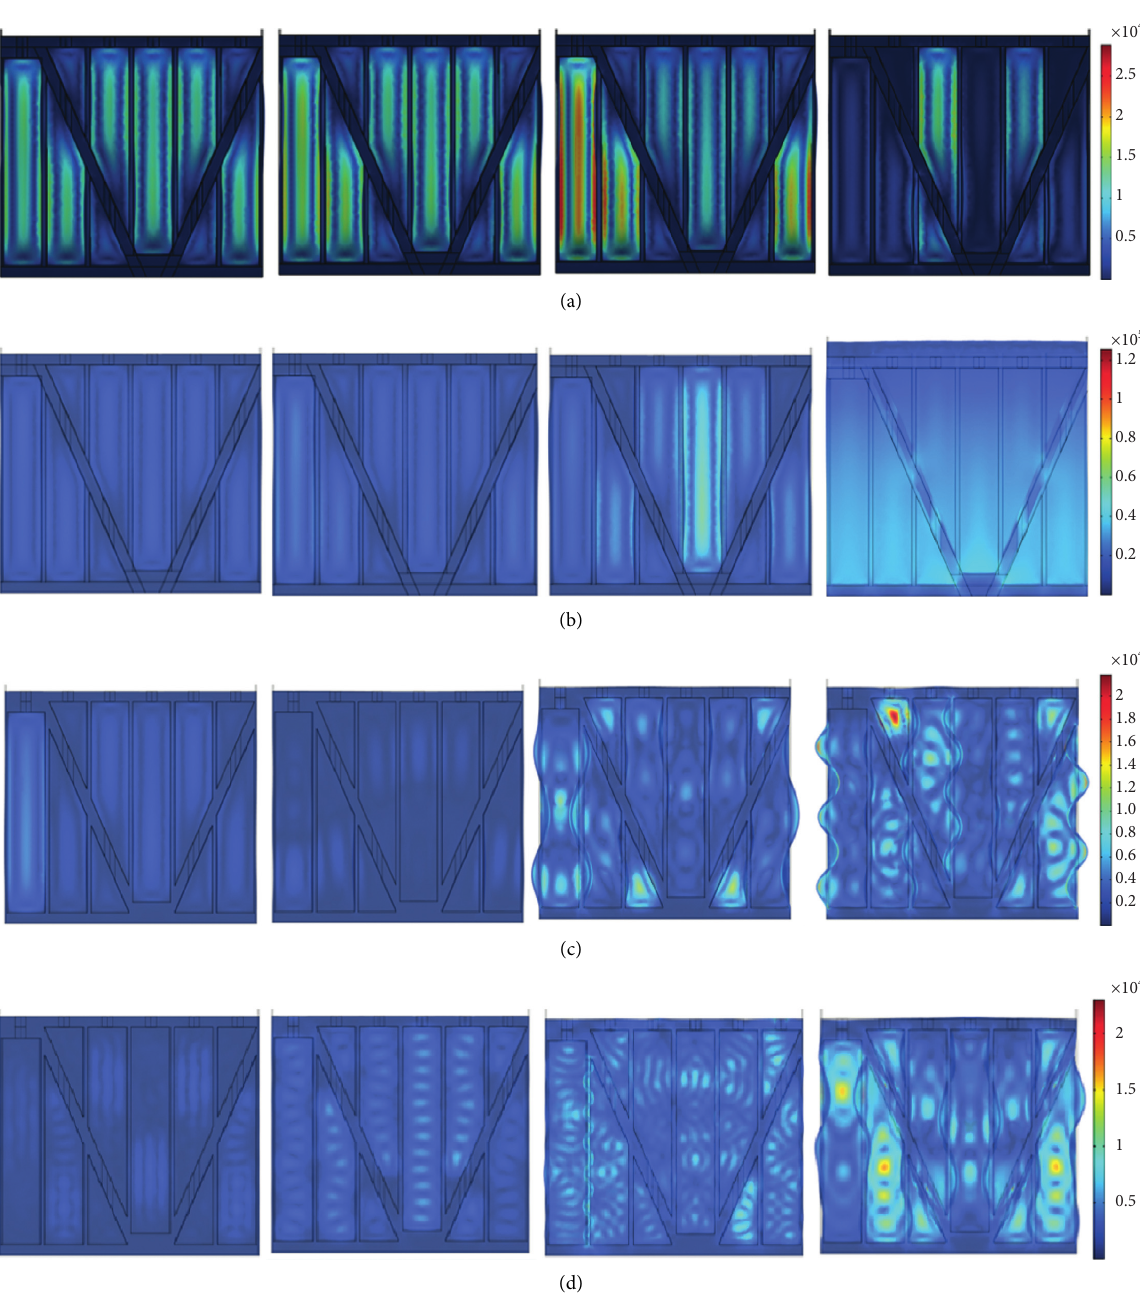
Figure 11: Structure deformation (amplified) and stress modes of each material at 500, 1000, 1500, and